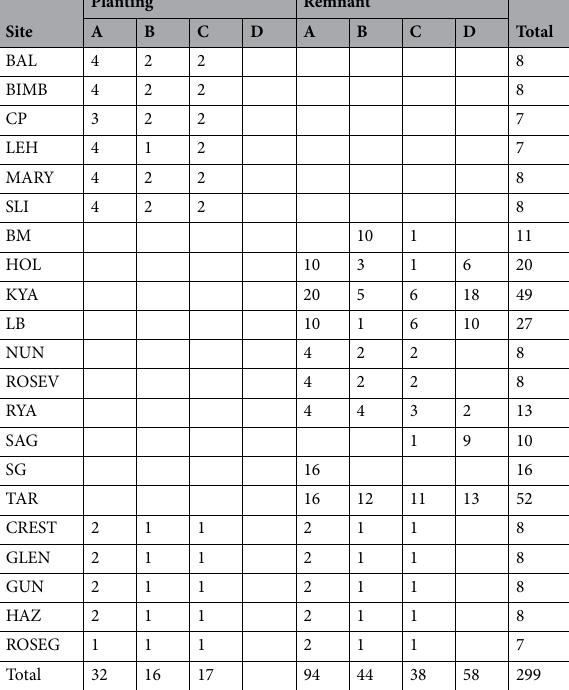
Table 2. Number of nest boxes by type (A, B, C, D), site (name given to a location), and site type (i.e., planting or